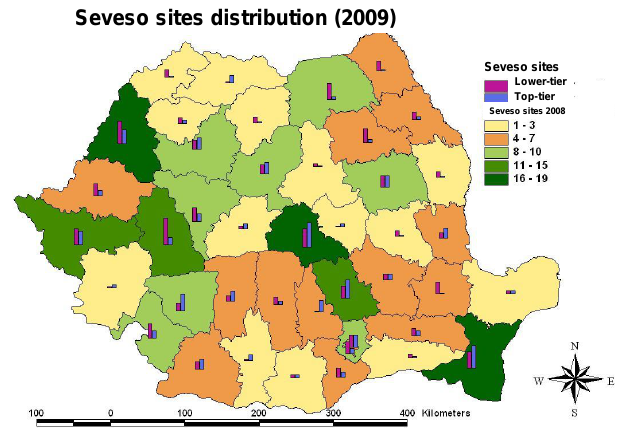
Fig. 2. Seveso sites distribution Figure 2. Seveso sites distribution (2009) 3